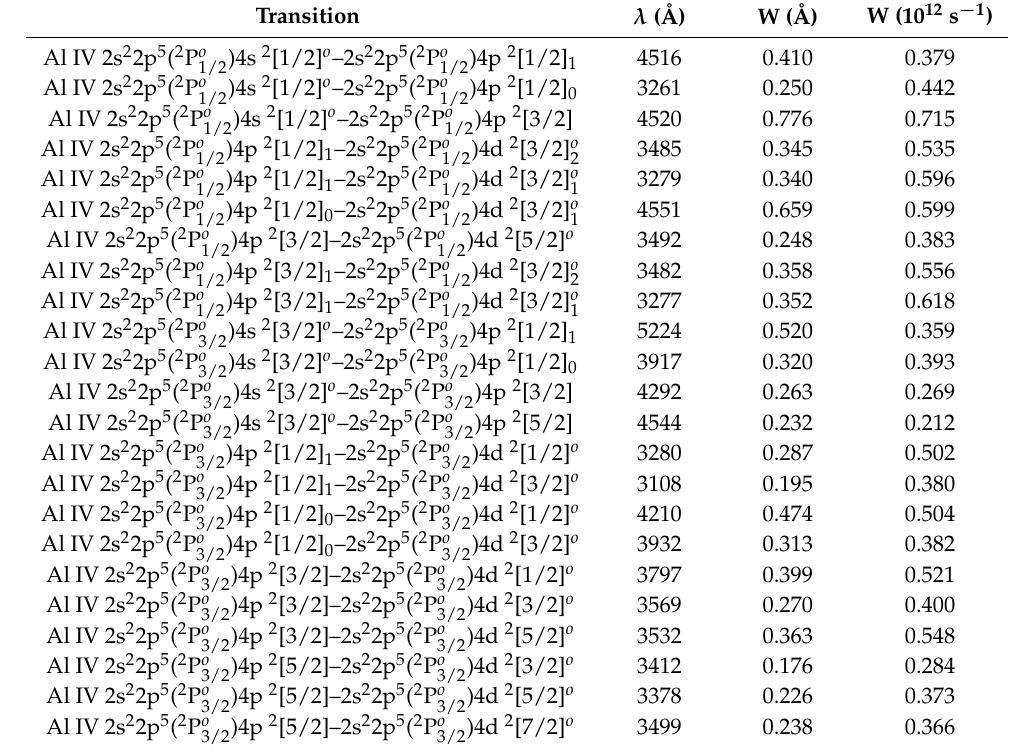
Table 2. Electron-impact broadening (Stark broadening), full widths at half intensity maximum (W) in (Å) and (10 12 s − 1 ) for Al IV spectral lines, for an electron density of 10 17 cm − 3 and T = 80,000